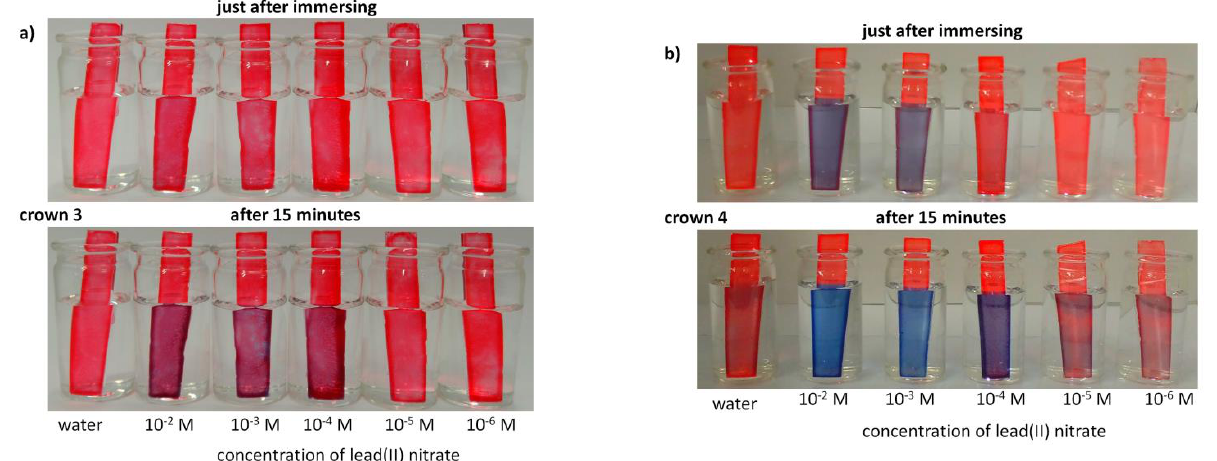
Figure 11. Color change of PVC based optodes bearing crown ( a ) 3 and ( b ) 4 upon immersion in solutions (pH 5) of lead(II) nitrate of different concentrations and, for comparison, in deionized water.